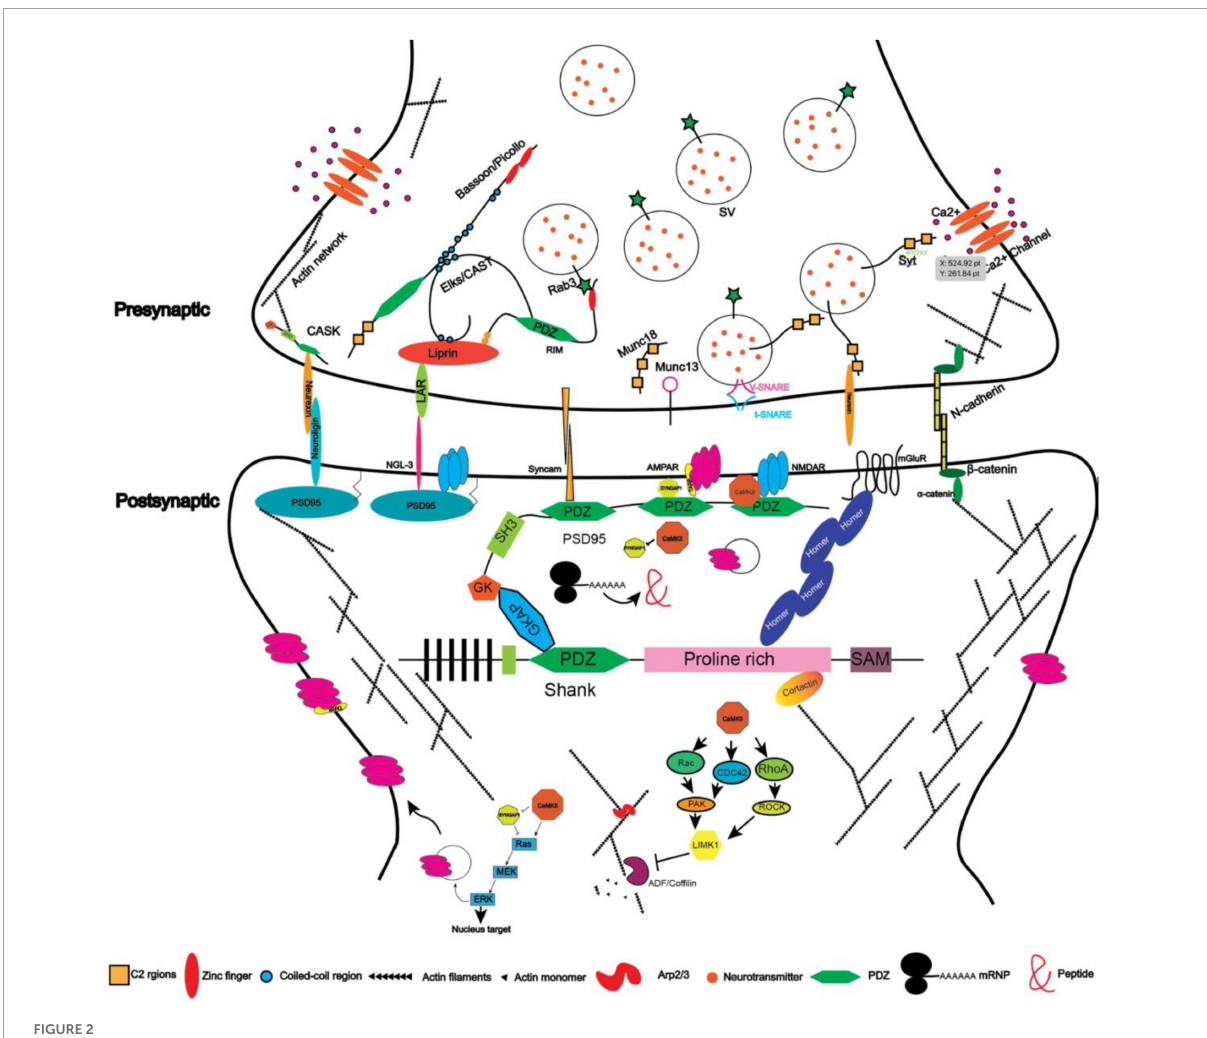
FIGURE2 Illustration depicting the protein network in excitatory synapses (protein size not scaled).